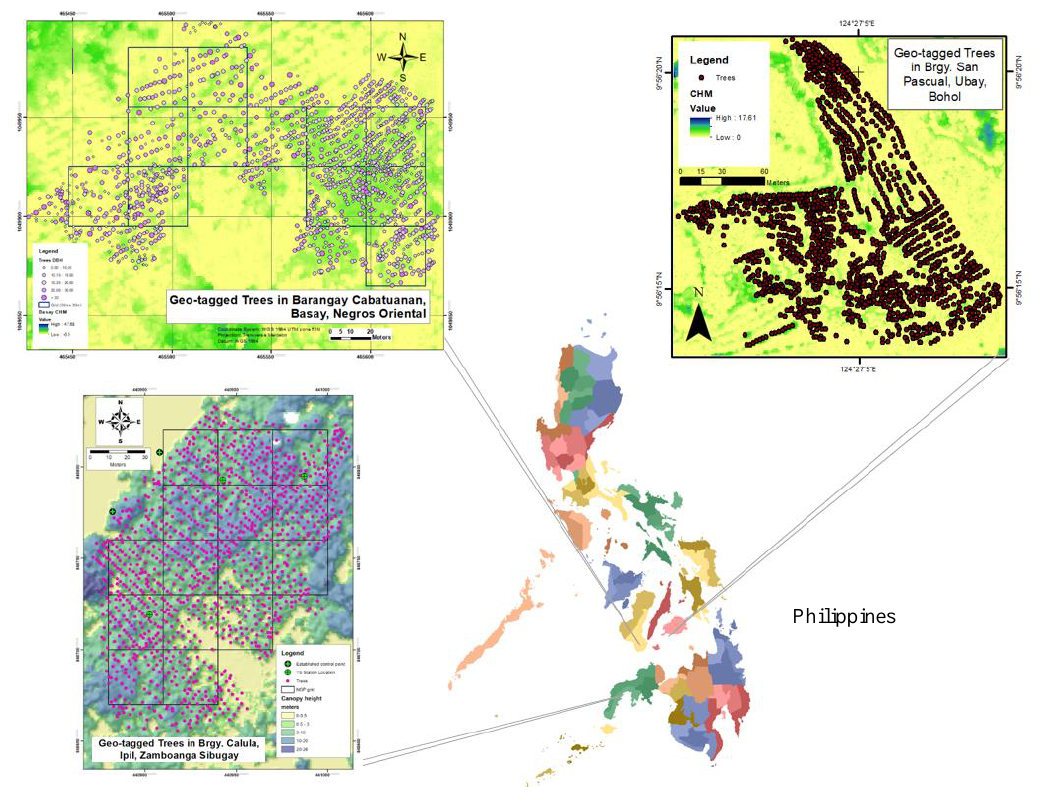
Figure 1. Location map of the study areas. Corresponding geo-tagged trees map of the NGP sites in Bohol, Zamboanga Sibugay, and Negros Oriental are